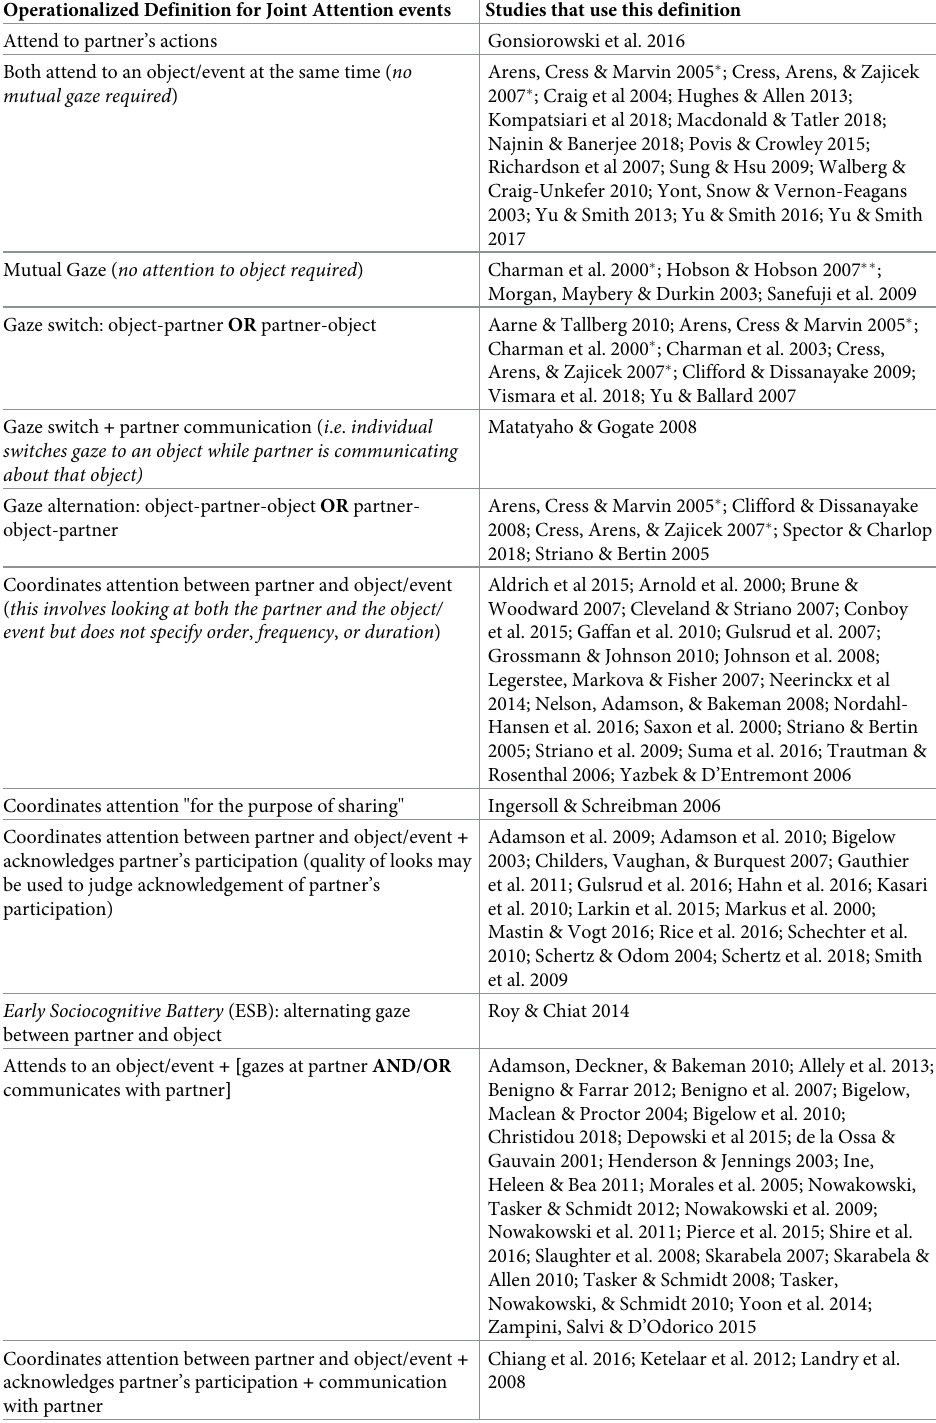
Table 1. A list of operationalized definitions of joint attention events used in papers between 2000 and 2018 that met criteria for our literature review; references